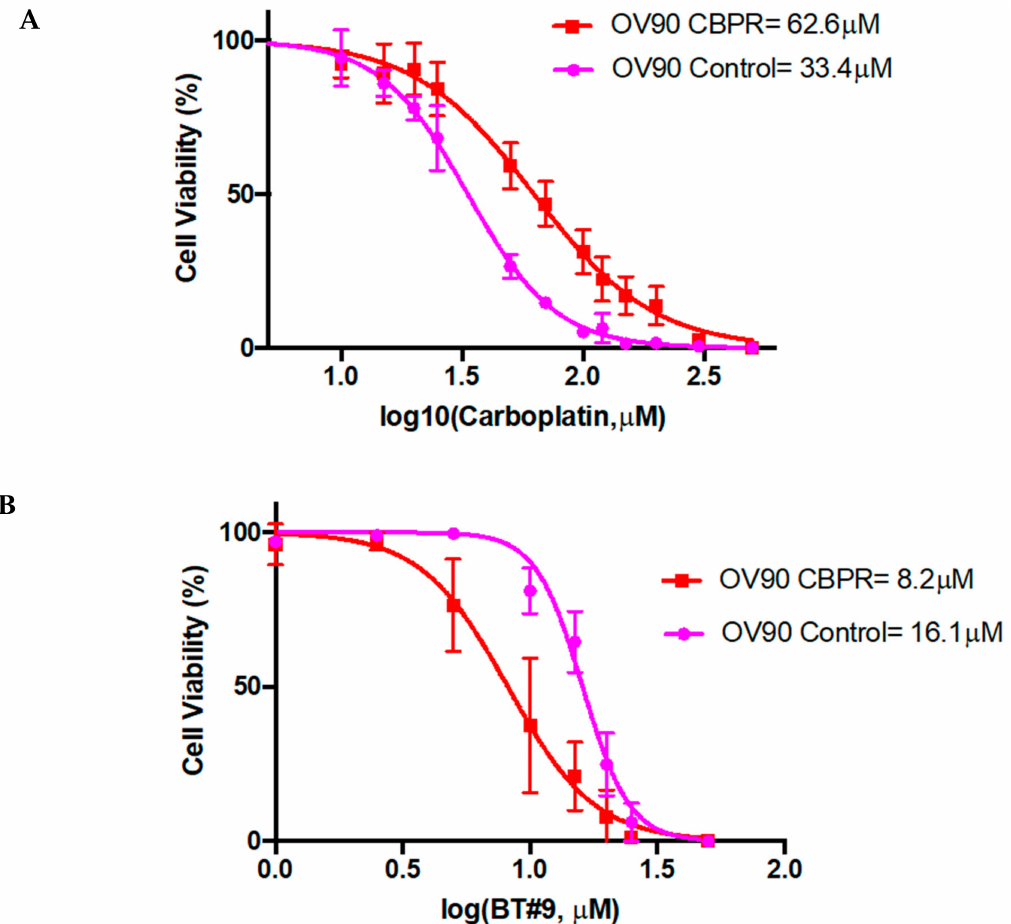
Figure 5. Sensitivity of OV90 parental (control) and carboplatin resistant (CBPR) ovarian cancer cells to carboplatin and Magmas inhibitor BT#9. OV90 parental control and OV90 CBPR cells (5 × 10 5 cells / well) were seeded and treated with varying concentrations of carboplatin and BT#9 drugs (carboplatin 72